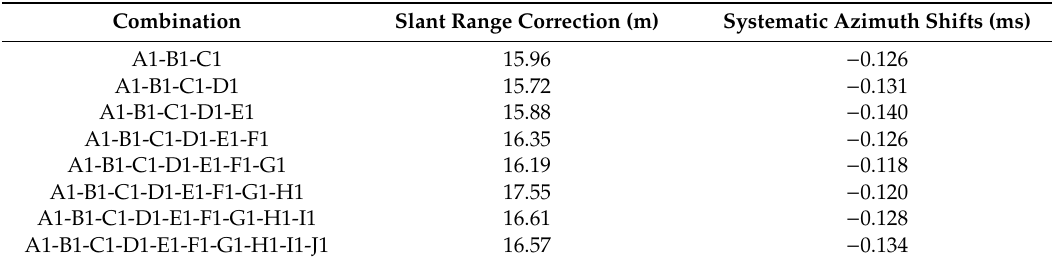
Table 3. Geometric calibration results for Calibration Group A (200 MHz and 24.4 µ s).